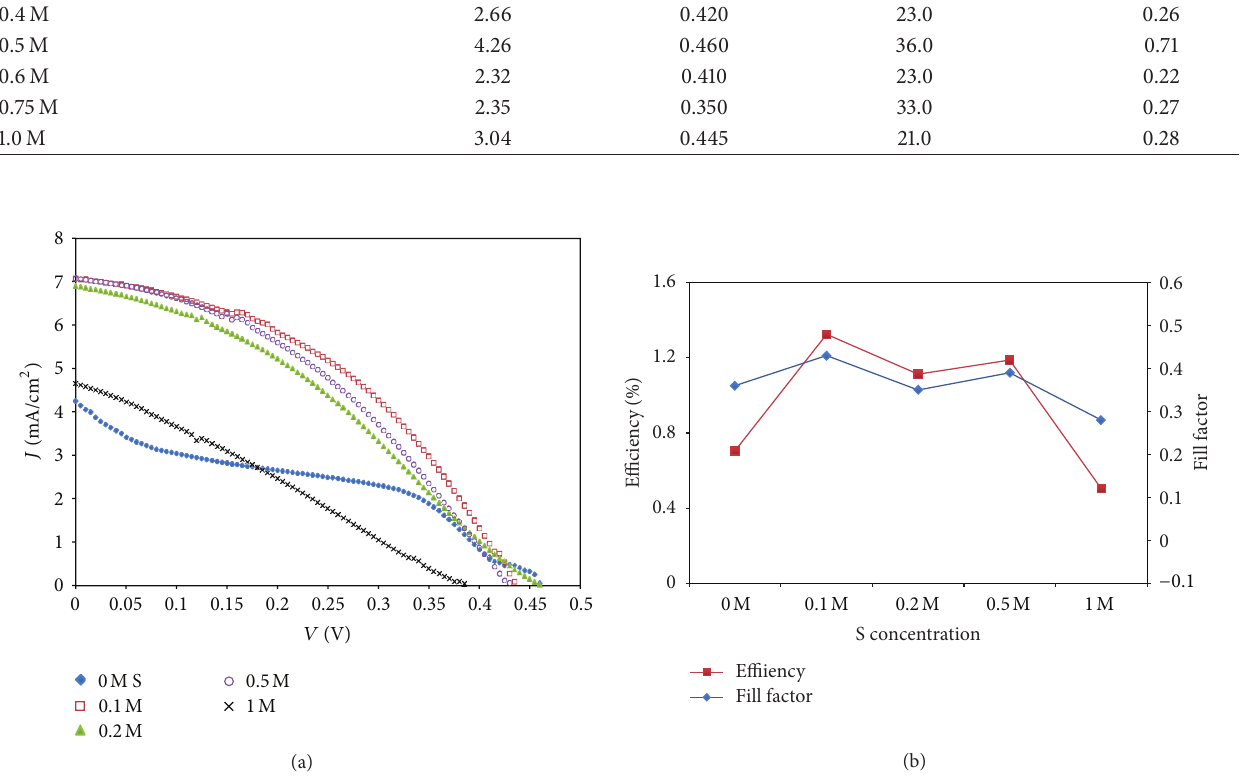
Figure 3: (a) 𝐽 - 𝑉 curves of CdSe QDSSCs with electrolytes having various amount of S. (b) Variation of efficiency and fill factor of the cells with the amount of S in the electrolyte. The electrolyte used: 0.5 M Na 2 S in ethanol/water (8:2 by